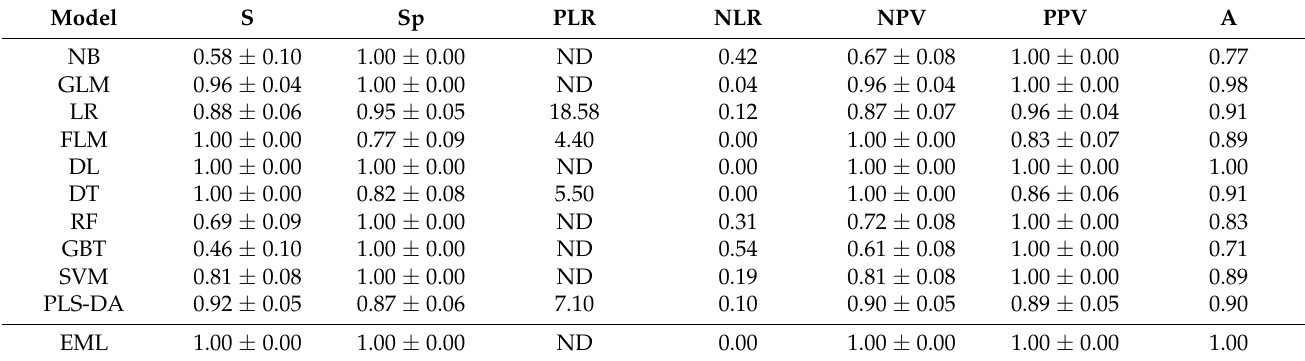
Table 2. Performance metrics (value ± standard error) of the individual and the ensembled machine learning classification algorithms when applied to the test set. Abbreviations; NB: Naïve Bayes, GLM: Generalized linear model, LR: Logistic regression, FLM: Fast large margin, DL: Deep learning, DT: Decision tree, RF: Random forest, GBT: Gradient boosted tree, SVM: Support vector machine,